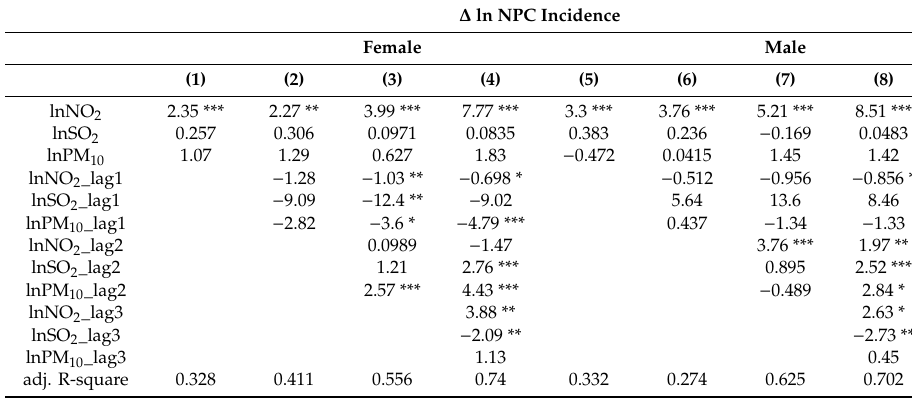
Table A3. Sensitive analysis of associations between air pollution and NPC incidence growth rate by sex.